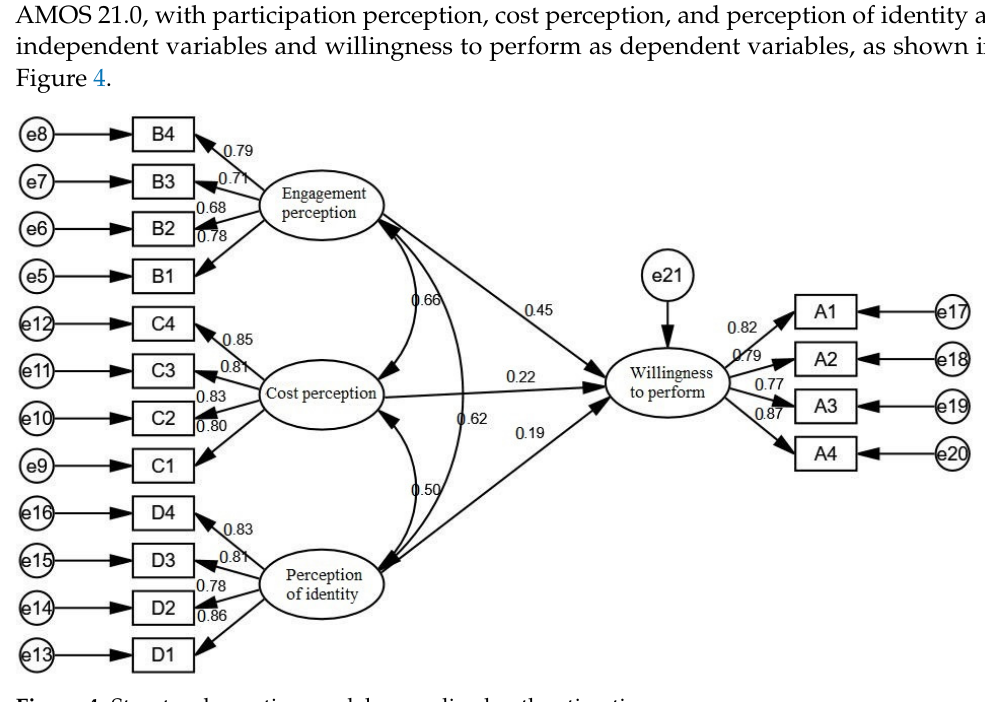
Table 12. Model fit goodness of fit index.